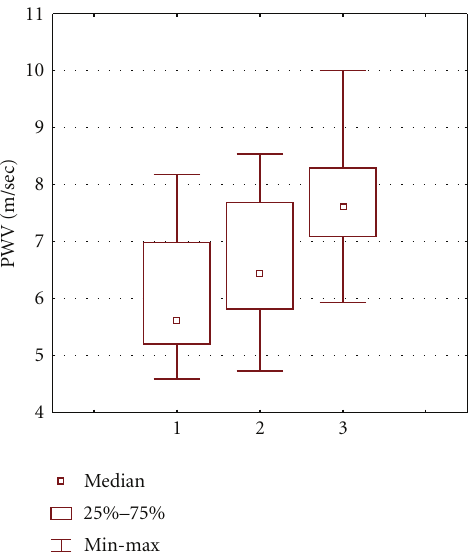
Figure 1: Aortic PWV in CAD patients. (1) one-vessel disease, (2) two-vessel disease, (3) triple-vessel disease. P < 0 . 01 (Kruskal- Wallis ANOVA by